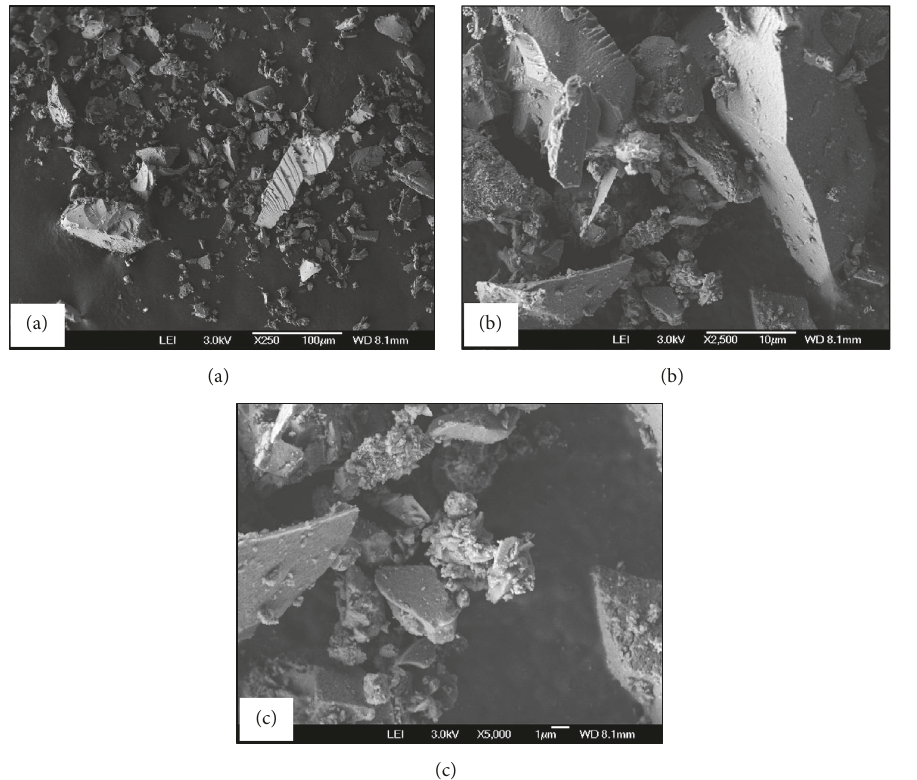
Figure 6: Scanning electron microscopy of biosilica. Magnification of 250x (a), 2500x (b), and 5000x (c).